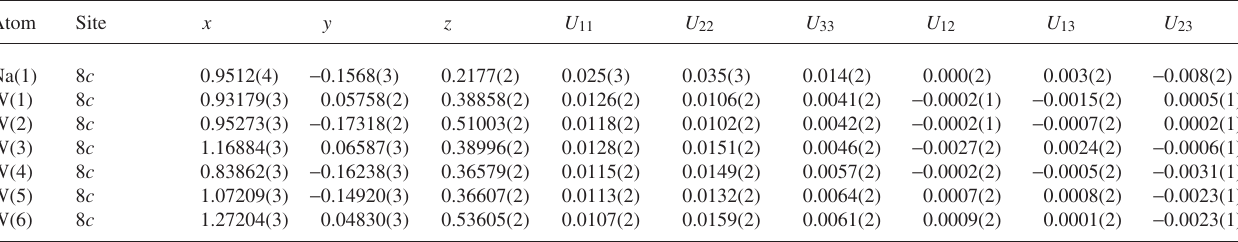
Table 3. Atomic coordinates and displacement parameters (in Å 2 )